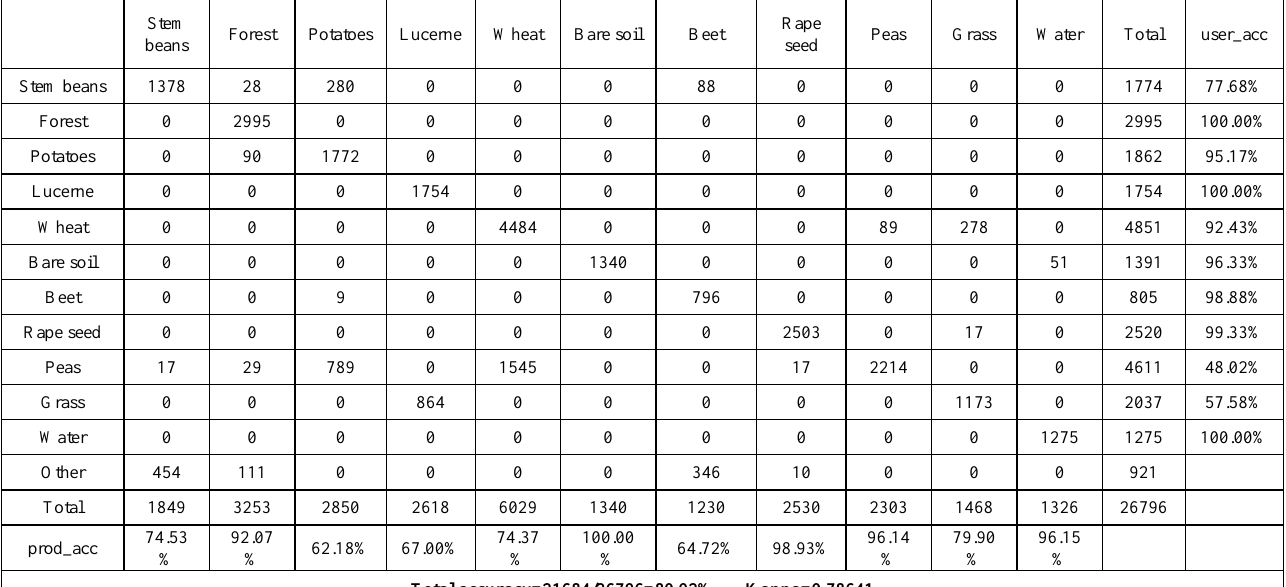
Table 2. Confusion matrix of the classification result using d